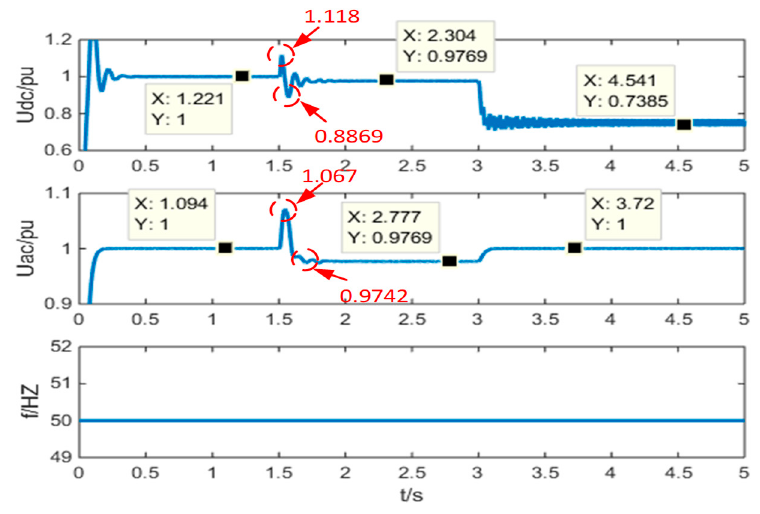
Figure 10. DC voltage, AC voltage, and frequency with the direct transition control.